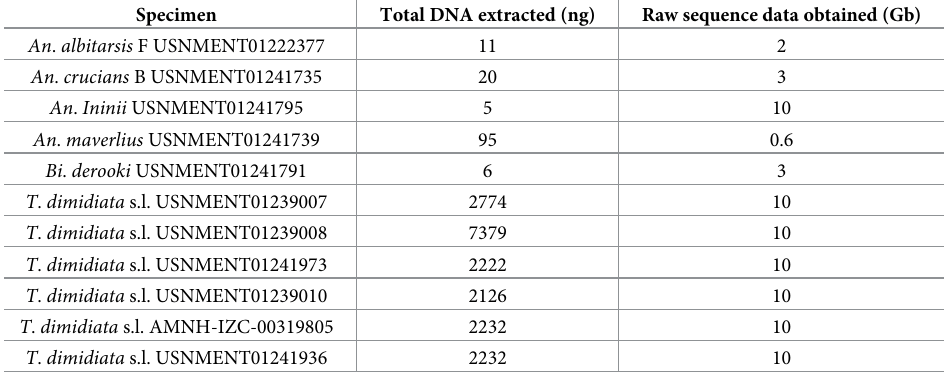
Table 2. Amount of total genomic DNA extracted and amount of raw data (i.e., raw reads in gigabases– 10 9 bp) obtained per specimen.